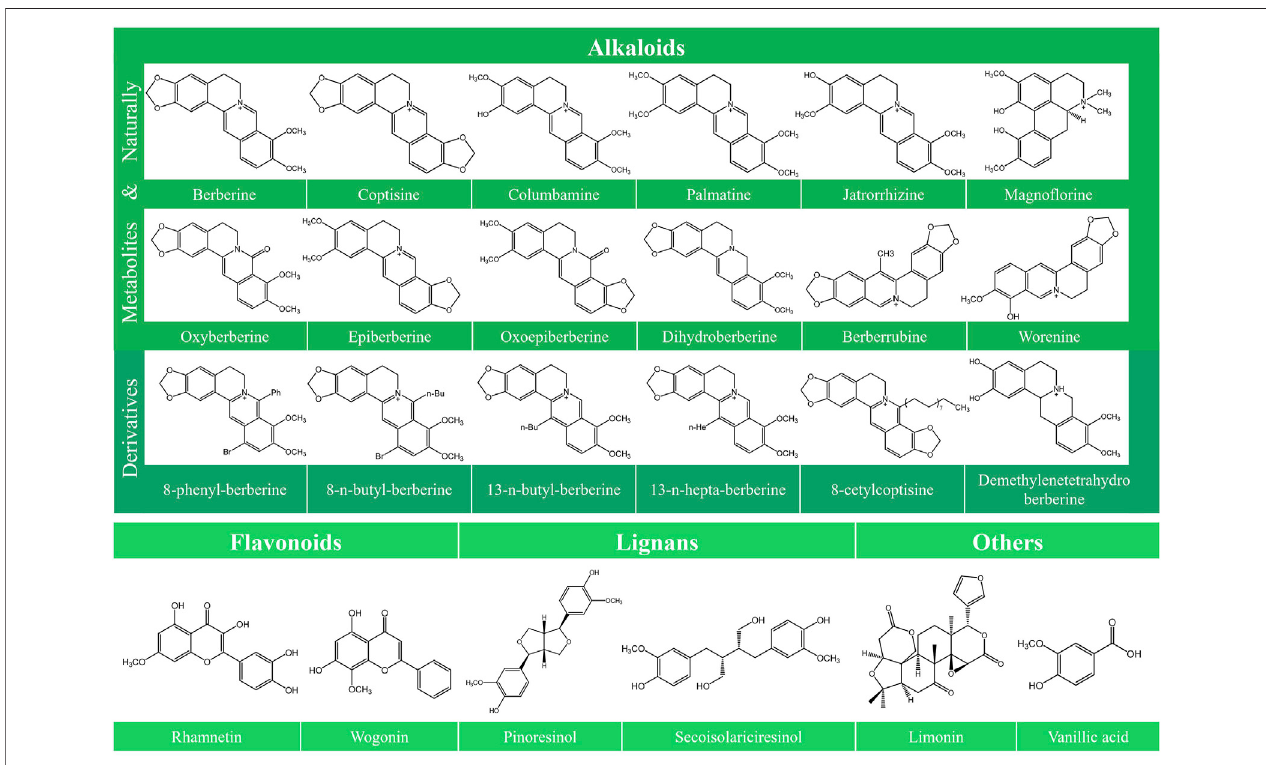
FIGURE 1 | Chemical structures of the constitutes derived from Coptidis Rhizoma . The chemical structures of the constitutes derived from Coptidis Rhizoma are shown, including Berberine, Coptisine, Columbamine, Palmatine, Jatrorrhizine, Magno fl orine, Oxyberberine, Epiberberine, Oxoepiberberine, Dihydroberberine, Berberrubine, Worenine, 8-phenyl-berberine, 8-n-butyl-berberine, 13-n-butyl-berberine, 13-n-hepta-berberine, 8-cetylcoptisine, Demethylenetetrahydroberberine, Rhamnetin, Wogonin, Pinoresinol, Secoisolariciresinol, Limonin, and Vanillic acid.